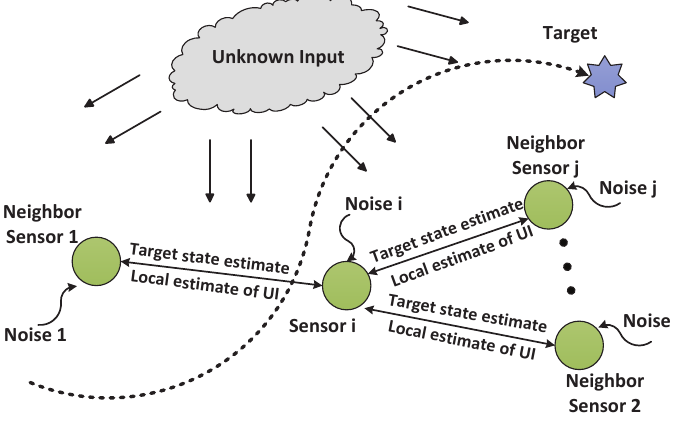
Figure 1. Collaborative target tracking in sensor